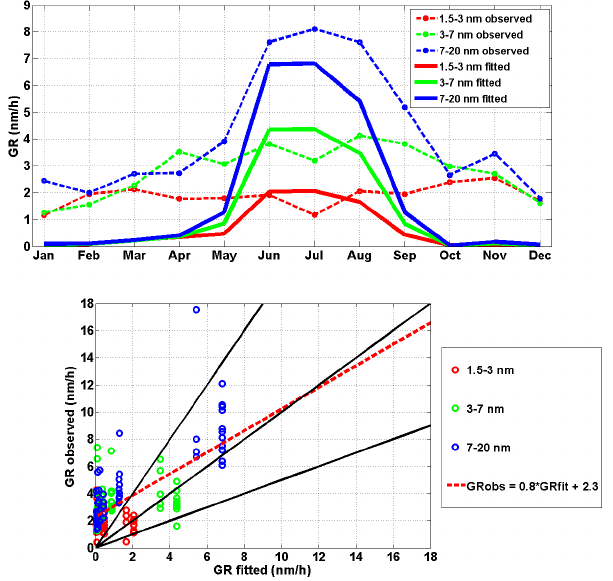
Fig. 4. Observed monthly median growth rates for three size classes during 2003–2009 in Hyyti¨al¨a (symbols and dashed lines) as well as the growth rates obtained from the mass flux fit (solid lines) when background mass flux is assumed to be zero (upper figure). The weighing factors for distributing the SORG MT (calculated using MT concentrations from GLOMAP) corresponding to the best fit were k MT , 1 . 5 − 3 = 0 . 2, k MT , 3 − 7 = 0 . 5 and k MT , 7 − 20 = 1 . 0. The correspondence between the growth rates from the mass flux fit and from the ambient observations is presented in the lower figure with a linear curve fitted to all the data points. Also 1 : 1, 2 : 1 and 1 : 2 lines (black lines) are shown. The fit can produce similar seasonal behavior as observed in the ambient conditions. However, the GRs are clearly underestimated during cold months when the emissions of MT are